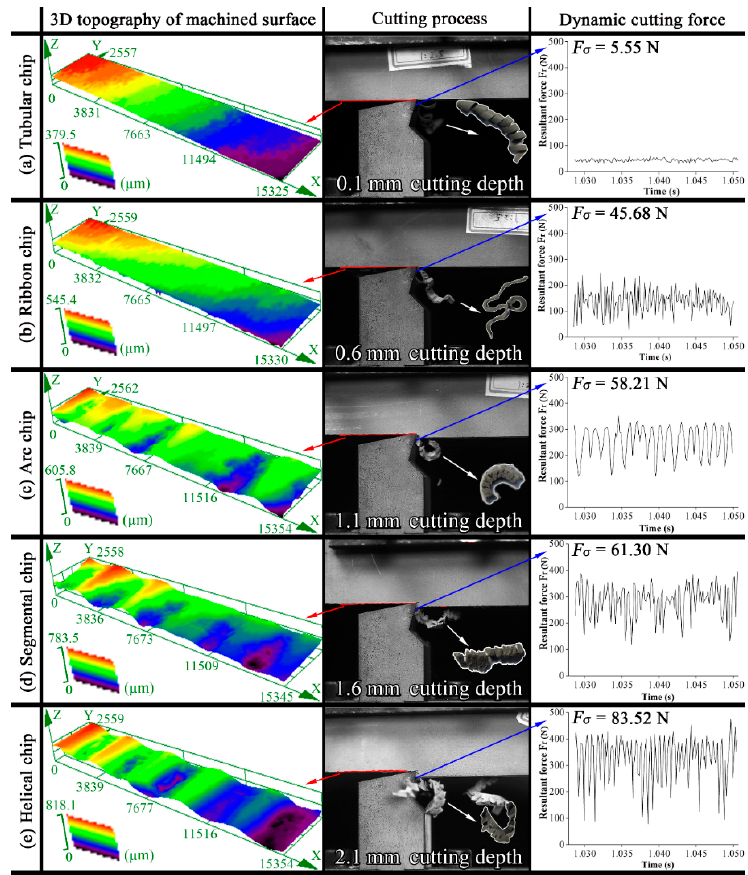
Figure 14. Relation between machined surface, resultant force, and chip shapes during machining at different cutting depths. different cutting